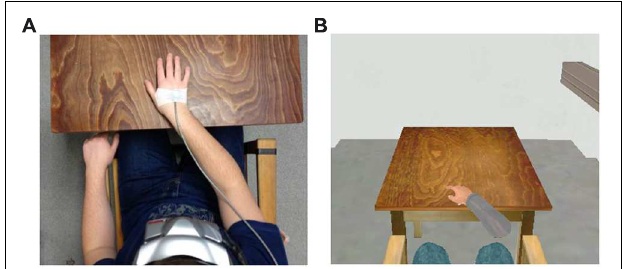
FIGURE 1 | Laboratory setup and corresponding VR scenario. (A) Laboratory setup, including head-mounted display (HMD) and hand tracking. (B) VR scenario including VR hand. Phobic stimuli not